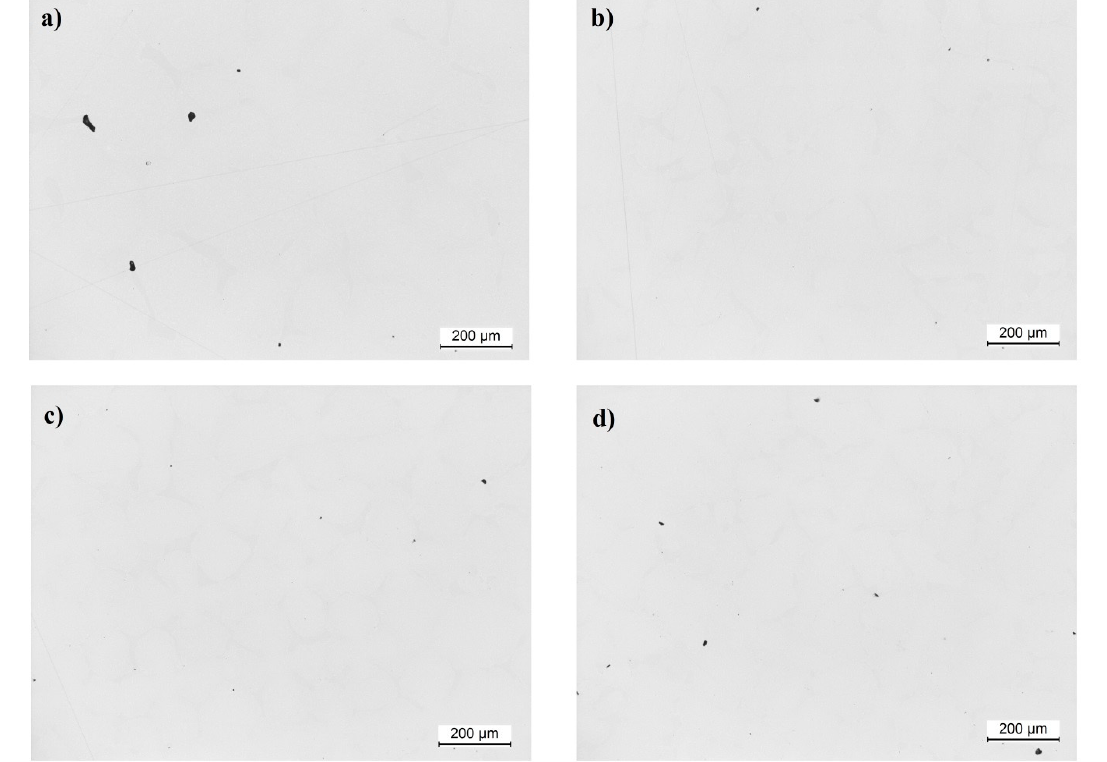
Figure 7. Micrographs of pores of cross-section of the CMSX-4 superalloy casting withdrawn at the rate of: ( a ) 1, ( b ) 3, ( c ) 5, ( d ) 7 mm / min.